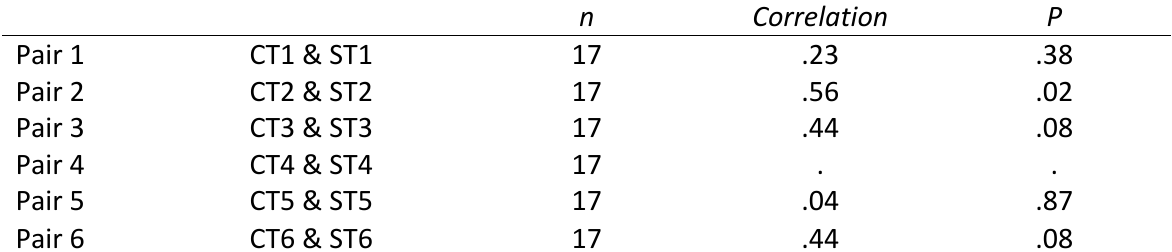
Paired Samples Correlations for Cooperating Teachers’ and Student Teachers’ Frequency of Best Practice Mentoring Behaviors